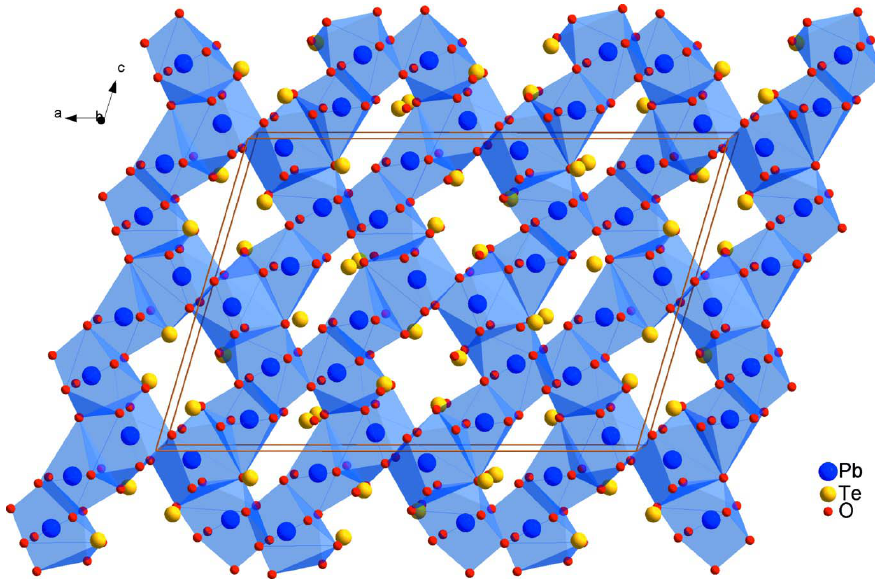
Figure 1 Polyhedral representation of the structure of α -PbTeO